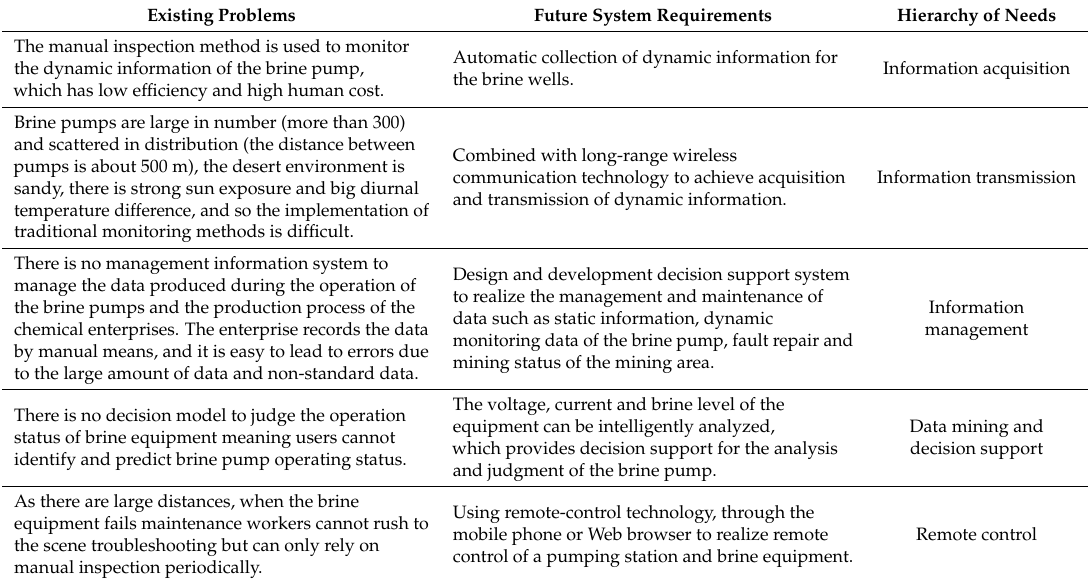
Table 3. Existing problems and system requirements of salt lake chemical enterprises.